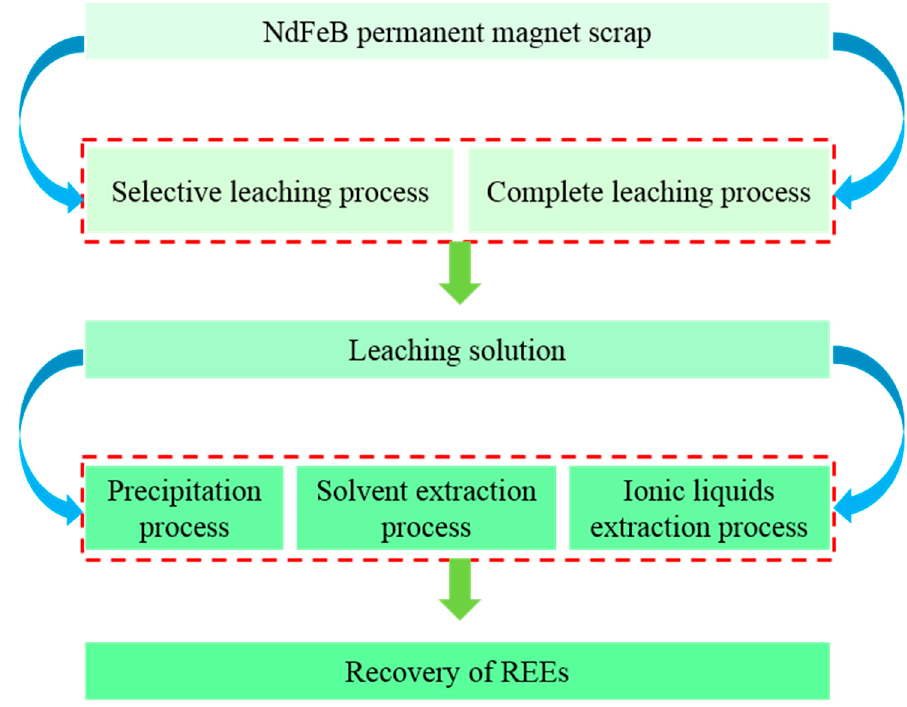
Figure 8. Schematic diagram of hydrometallurgical processes.